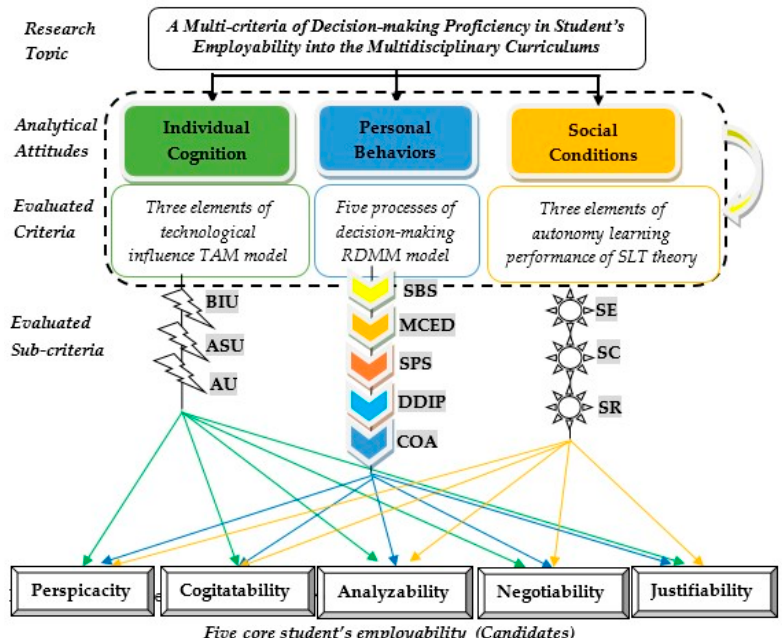
Figure 6. Research design empirical framework.